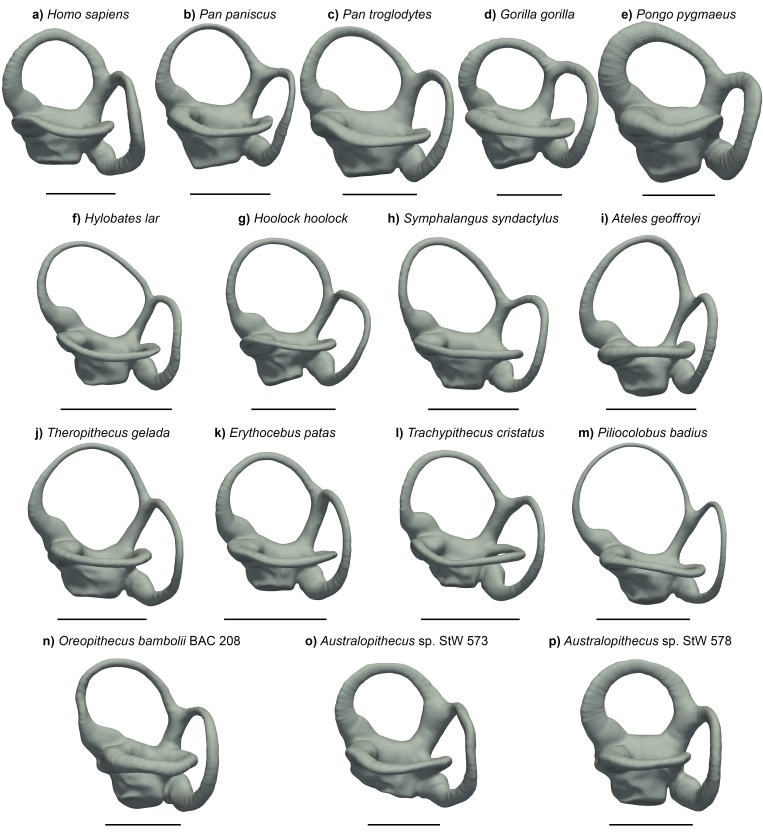
The vestibular apparatus of extant hominoids, other anthropoids, and some fossil hominoids, in lateral view.(a) Homo sapiens (EMBR 121); (b) Pan paniscus (MCZ 38019); (c) Pan troglodytes (AMNH.M 51204); (d) Gorilla gorilla (AMNH.M 167338); (e) Pongo pygmaeus (IPS 10647); (f) Hylobates lar (MCZ 41424); (g) Hoolock hoolock (AMNH.M 83425); (h) Symphalangus syndactylus (AMNH.M 106583); (i) Ateles geoffroyi (MCZ 29628); (j) Theropithecus gelada (AMNH.M 60568); (k) Erythrocebus patas (MCZ 47017); (l) Trachypithecus cristatus (MCZ 35597); (m) Piliocolobus badius (MCZ 24793); (n) Oreopithecus bambolii (BAC 208); (o) Australopithecus sp. (StW 573); (p) Australopithecus sp. (StW 578). Scale bars equal 5 mm.